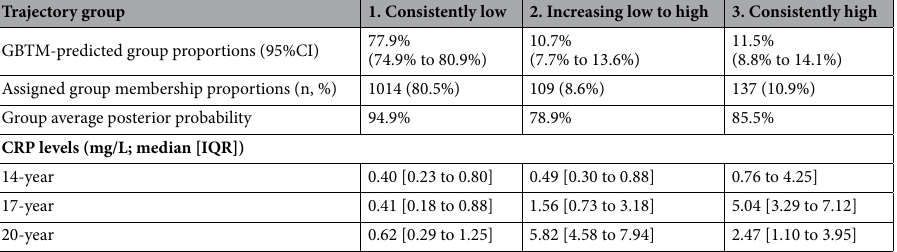
Table 1. Estimated group proportions and assigned group membership proportions for the 3 CRP trajectories. CI = confidence interval; CRP = C-reactive protein; GBTM = group-based trajectory modelling; IQR = interquartile